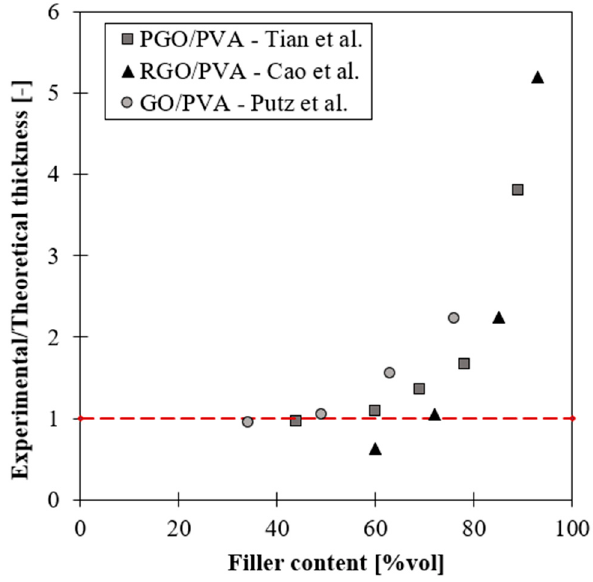
Figure 8. Comparison between experimental and theoretical matrix thickness in GO/PVA composites as function of filler content.